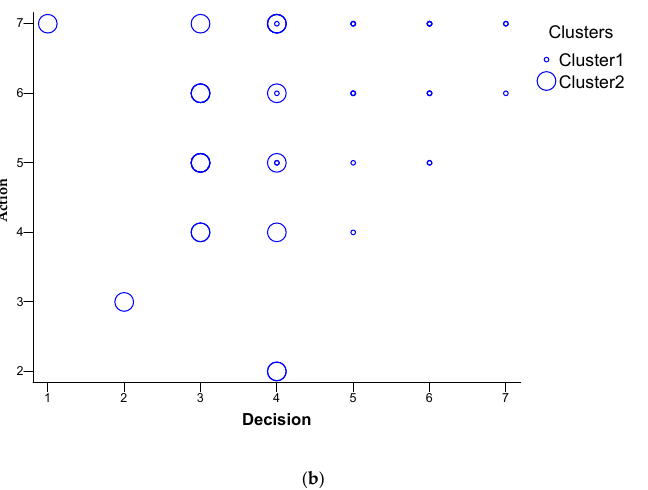
Figure 10. Graphical representation of the clusters formulated from subjective evaluation of the shuttles KH. ( a ) Perception and analysis functions; ( b ) decision and action functions.